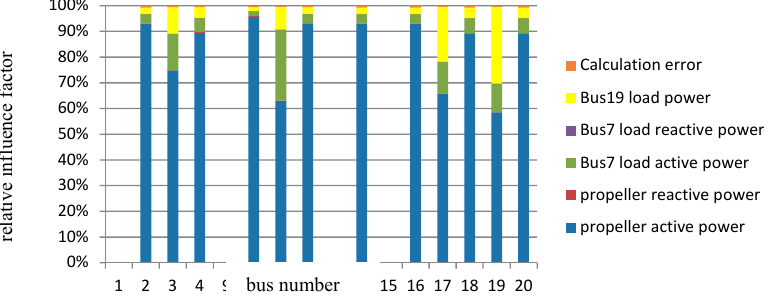
η of load variations for bus voltages. i